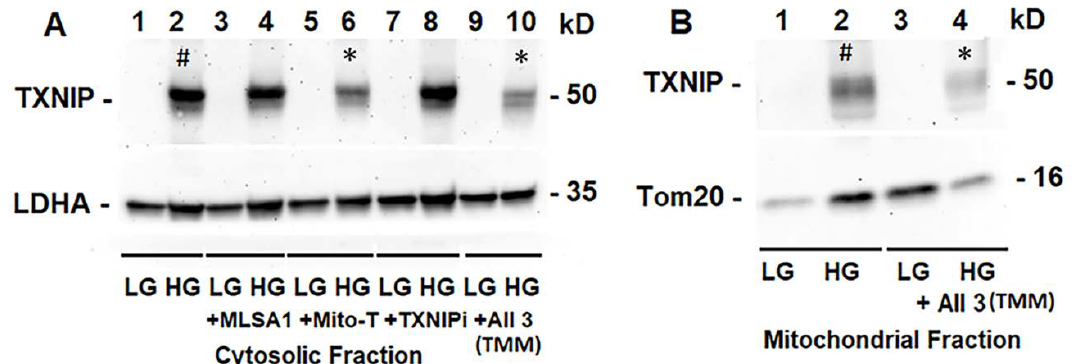
Figure 5. HG induces TXNIP expression and triple drug combination treatment reduces TXNIP in rMC1. ( A ) On Western